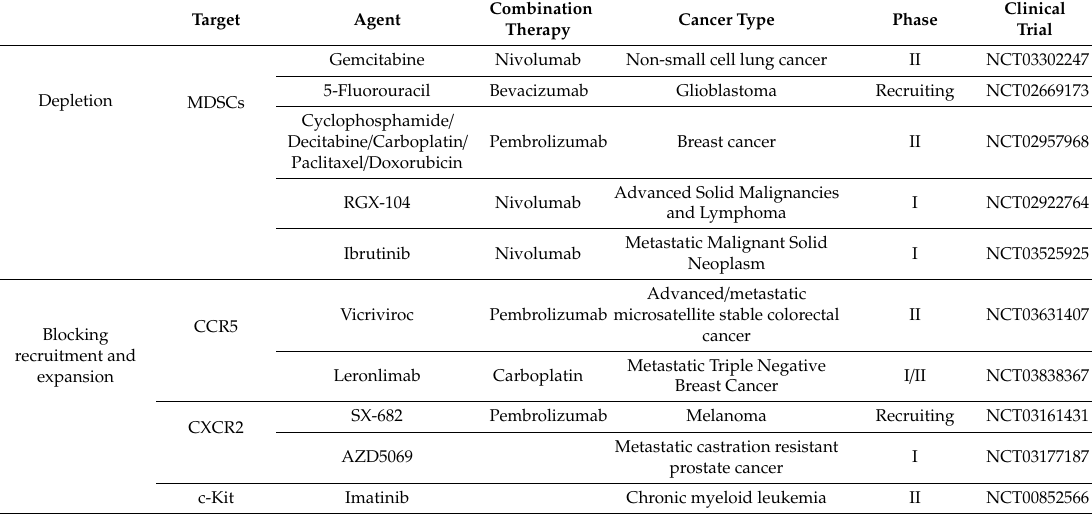
Table 5. Clinical trials targeting